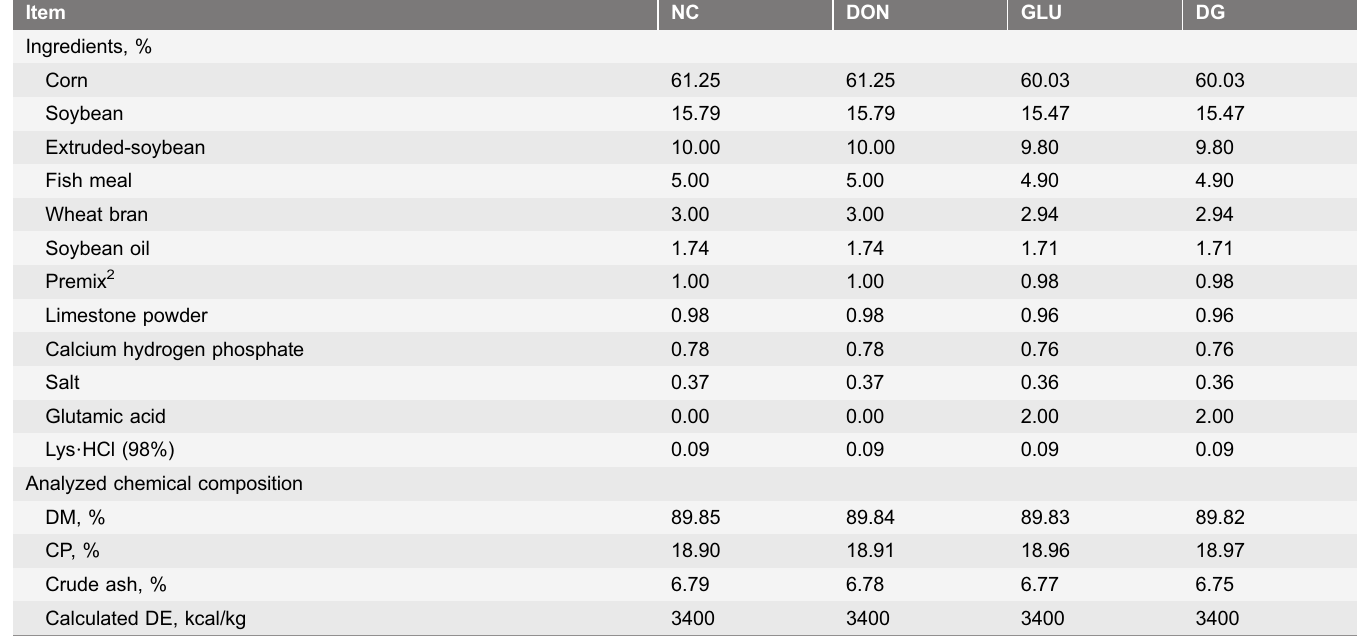
Table 1. Composition and nutrient levels of basal diet (as-fed basis) 1